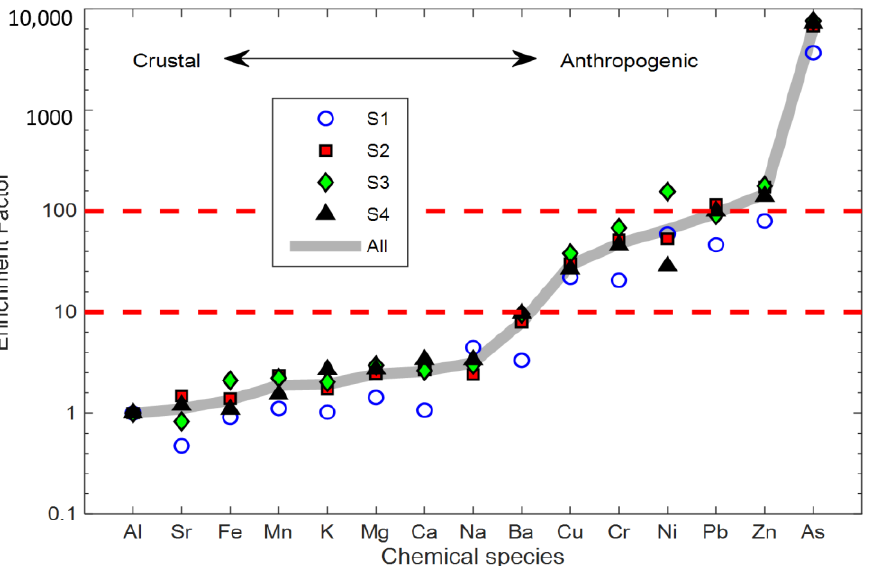
Figure 7. Enrichment factors calculated using Al as a reference element during the whole sampling period.